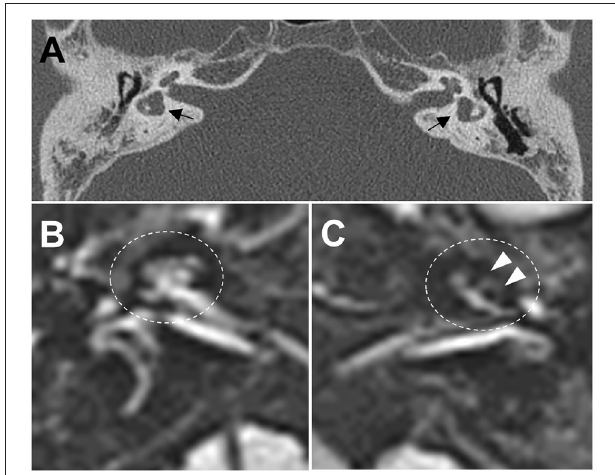
FIGURE 2 | (A) Computed tomography images of the temporal bone demonstrate bilateral widening of the vestibules with an abnormally small bony island of lateral semicircular canals (black arrows) and soft tissue densities in the middle ear, and decreased mastoid air cells. (B,C) Axial three-dimensional fluid-attenuated inversion recovery images obtained 4h after intravenous administration of gadolinium reveal cochlear endolymphatic hydrops (EH) with dilation of the scala media in the left ear ( C , white arrows), but no EH in the right ear (B)